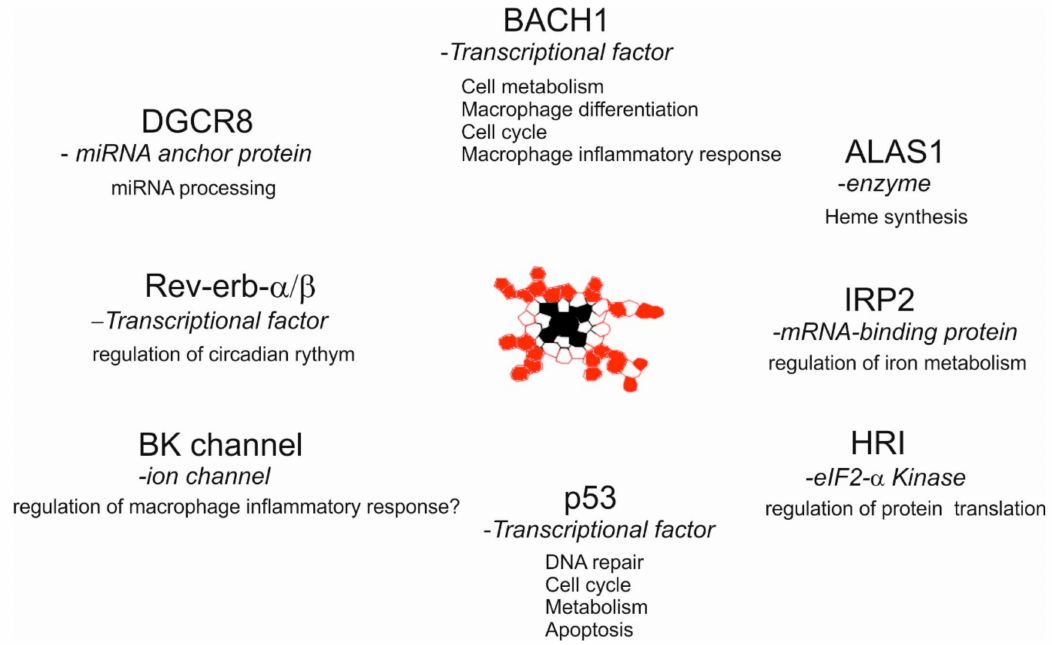
Figure 1. Heme-mediated control of cellular functions via heme sensor proteins. Intracellular labile heme may control various aspects of macrophage functions via binding and modulation of the indicated proteins through their heme regulatory motifs (CP / CXXH / PC). Iron regulatory protein 2 (IRP2);5’-Amino levulinate synthase-1 (ALAS1); Heme regulated eIF2-a kinase (HRI); DiGeorge syndrome critical region 8 (DGCR8); Big potassium